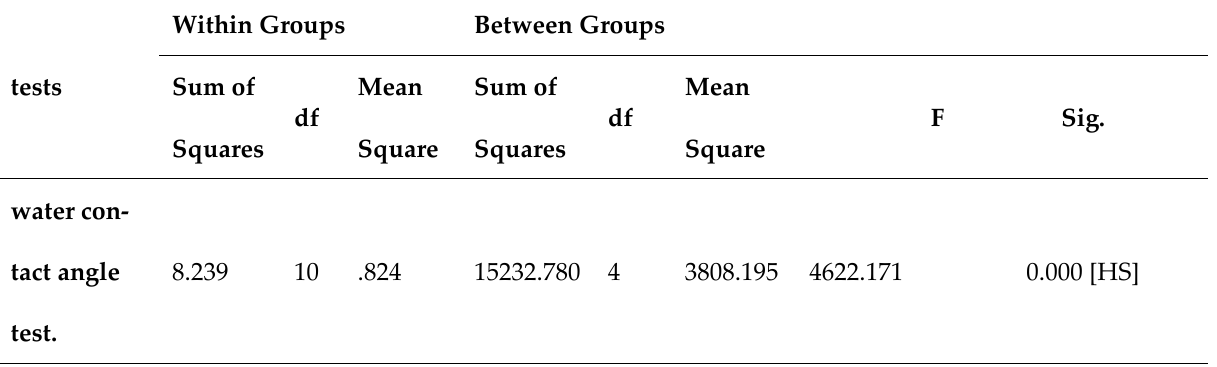
Table 3: ANOVA test of water contact angle test